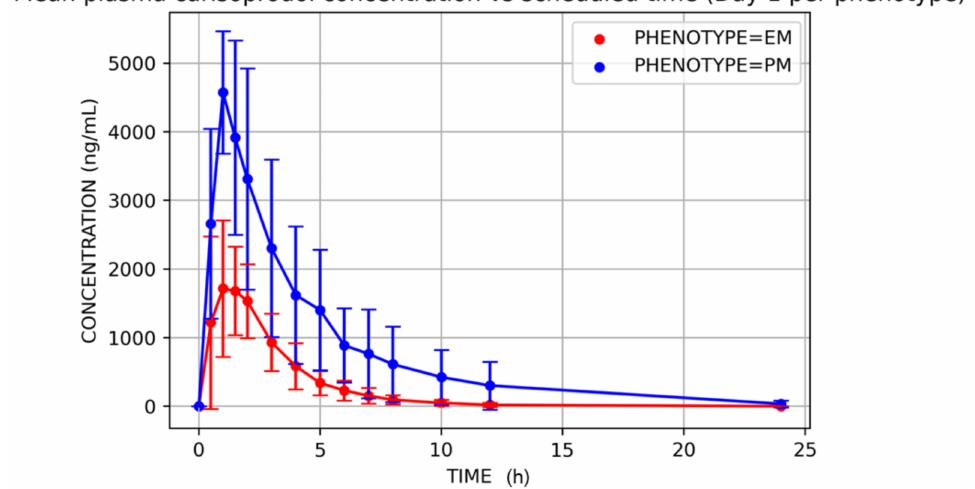
Figure 5. Mean plasma carisoprodol concentration vs. time, D1, by phenotype. EM = extensive metabolizer; PM = poor